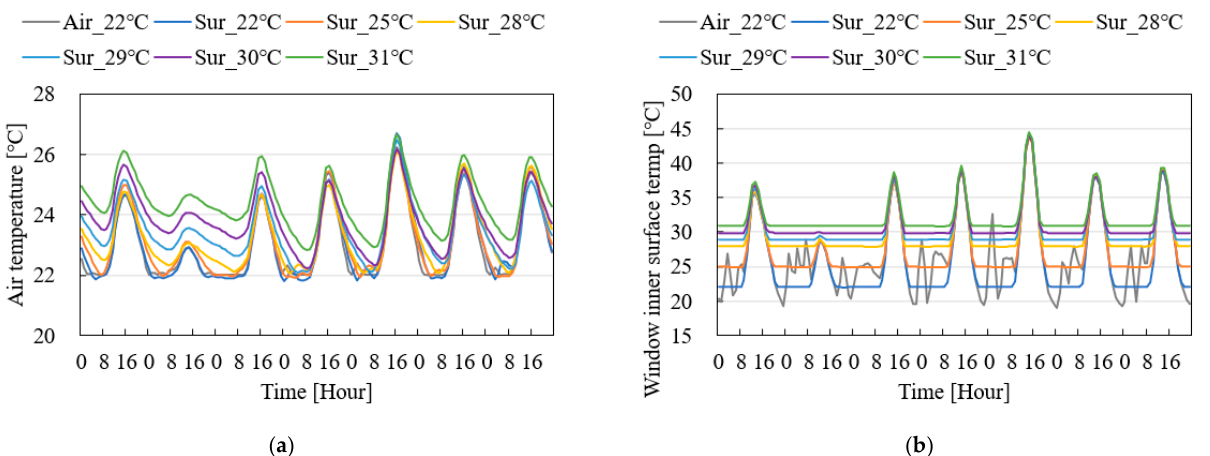
Figure 18. Air temperature of the glass zone and the inner surface temperature of the window. ( a ) Air temperature of glass zone; ( b ) Window inner surface temperature.